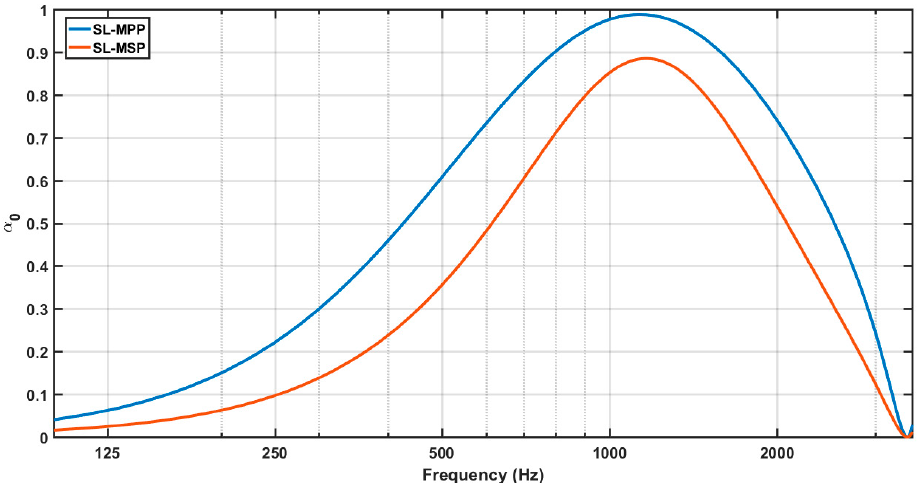
Figure 15. Comparison of the absorption curves of an SL-MSP and an equivalent SL-MPP for ( d , t , φ , D ) = (0.15 mm,1 mm,5%,5 cm).